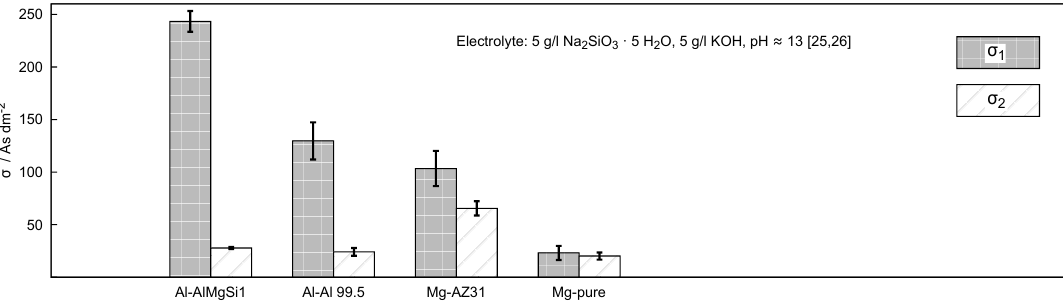
Figure 5. Comparison of the σ -values of the measurements shown in Figure